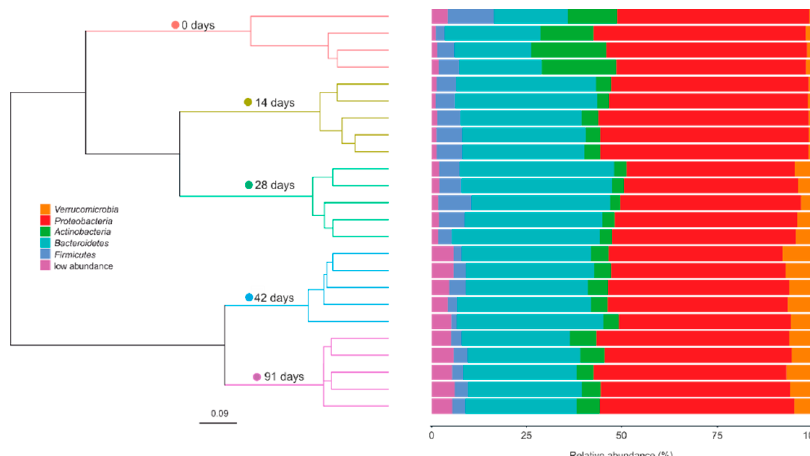
Figure 2. Changes in the bacterial community composition (phylum level) during vermicomposting of grape marc derived from the red winemaking process of the grape variety Mencía. The dendrogram represents the dissimilarity of bacterial communities at ASV levels (unweighted UniFrac distances, Ward method). Bars represent the relative abundance of dominant bacterial phyla. Bacterial phyla with lower relative abundances (<1%) were grouped together.